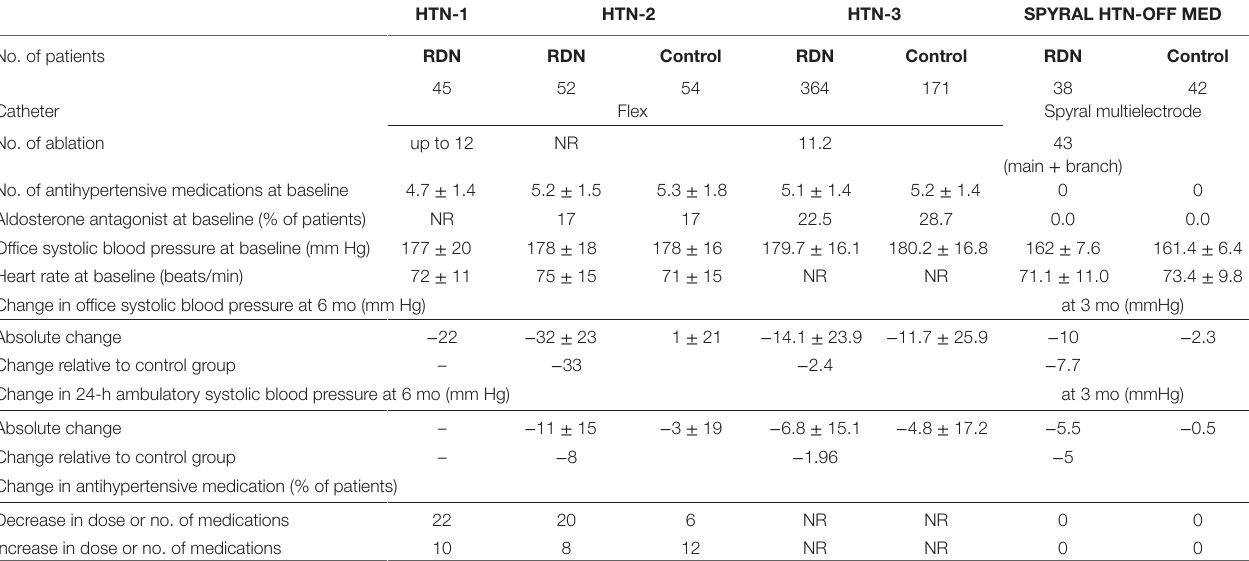
TABLe 1 | Summary and demographics of Symplicity